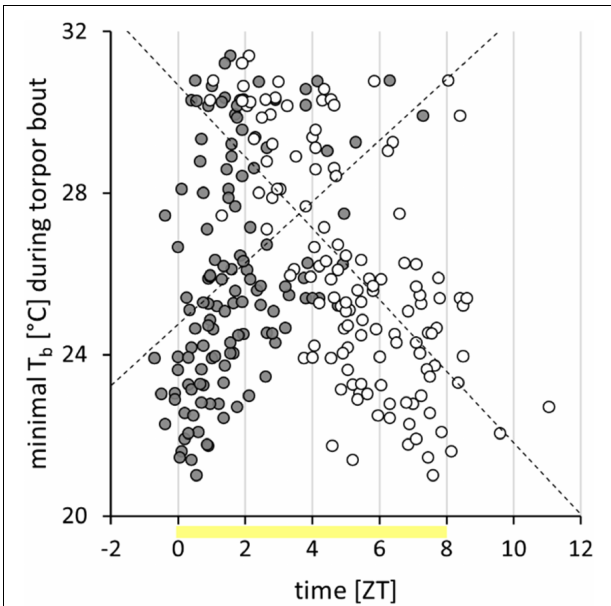
FIGURE 3 | Torpor characteristics of approach 1. Within the torpor analysis week, 127 torpor bouts, performed by 42 Djungarian hamsters, were examined. Of each bout, the torpor onset ( gray circles ) and the torpor offset ( white circles ) are shown. The minimal body temperature ( T b ) during each torpor bout is positively correlated with its onset ( r = 0.385, p < 0.05) and negatively correlated with its offset ( r = -0.628, p < 0.05). Most bouts were performed within the photophase ( yellow